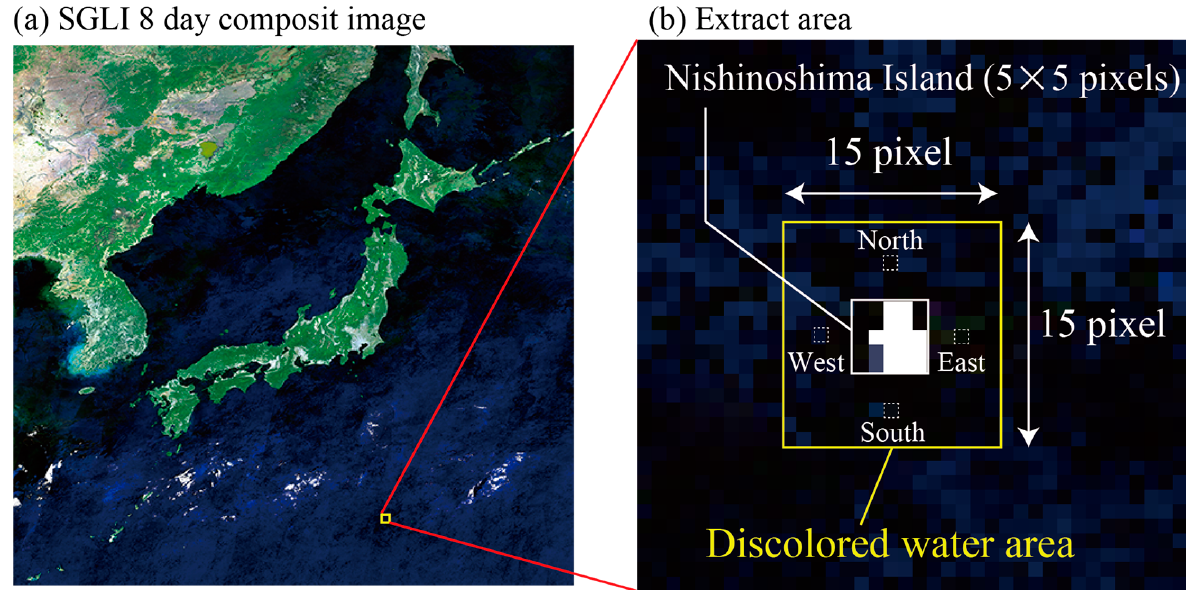
Figure 2. An example of the atmospheric corrected reflectance 8 day composite data of SGLI around Nishinoshima Island, Japan.